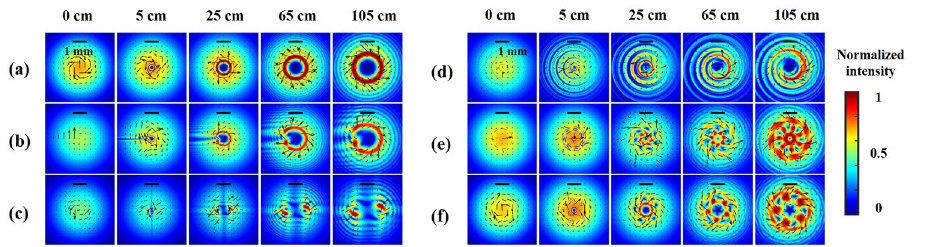
Figure 3. Theoretical diffraction intensities along the beam propagation direction using the angular spectrum method. Each case corresponds to that in Fig. 2. The arrows in all the results represent the direction of the OFD. The intensity distribution of each figure is normalized to unity. The scale bar in the top of each figure is about 1